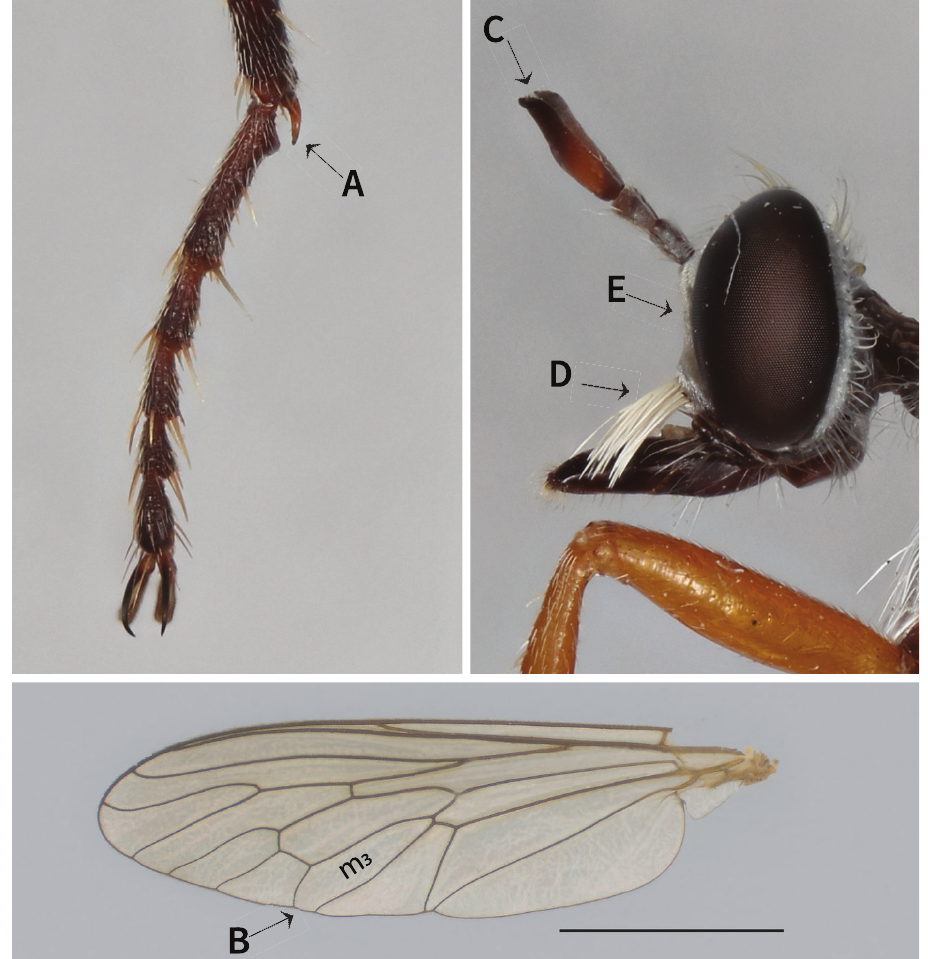
Figure 3. Saropogon nitidus illustrating distinguishing characters of the genus A fore tibia with a distinct spur. B open m cell on wing C antennal style D mystax of S. nitidus restricted to oral margin E face 3 slightly concave. Scale bar: 2